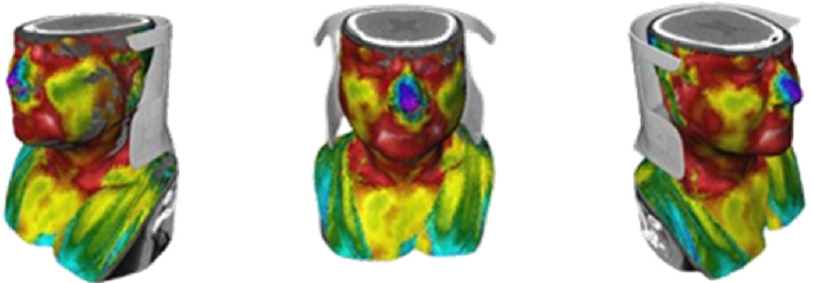
Figure 19. The results were visualized after the fusion between the 3D thermal shell (external) with the DICOM data (internal).